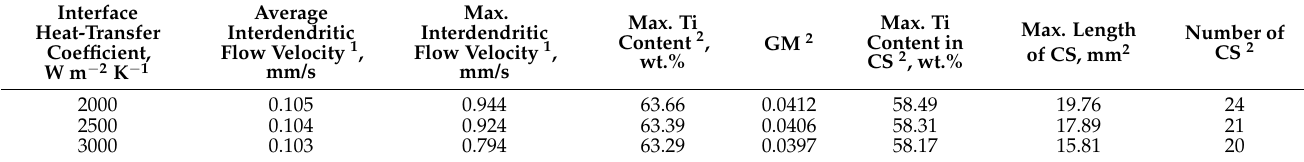
Table 3. The interdendritic flow velocity and segregation extent during solidification with different cooling